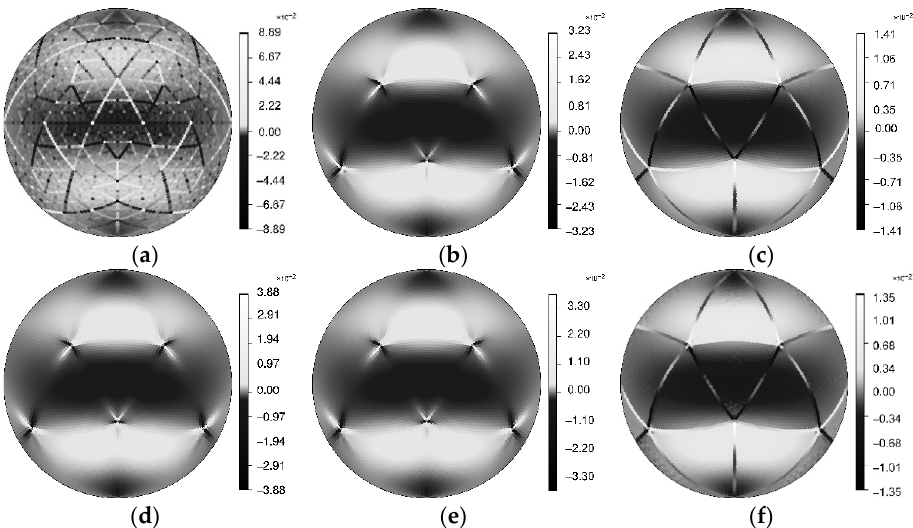
Figure 15. Spherical distributions of Laplacian operator error of different grids. ( a ) NOPT grid. ( b ) SPRG grid. ( c ) HR grid. ( d ) SCVT grid. ( e ) XU grid. ( f ) OURS grid.